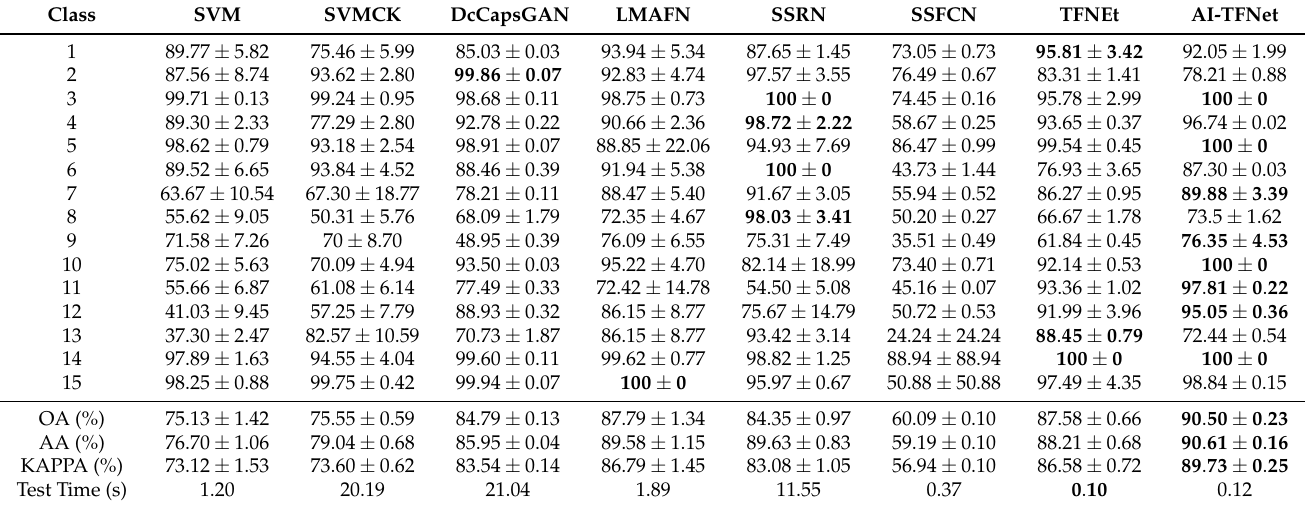
Table 10. Classification accuracy of different methods on the Houston dataset with 10 labeled samples for 10 random iterations. (The best results in each row are represented in